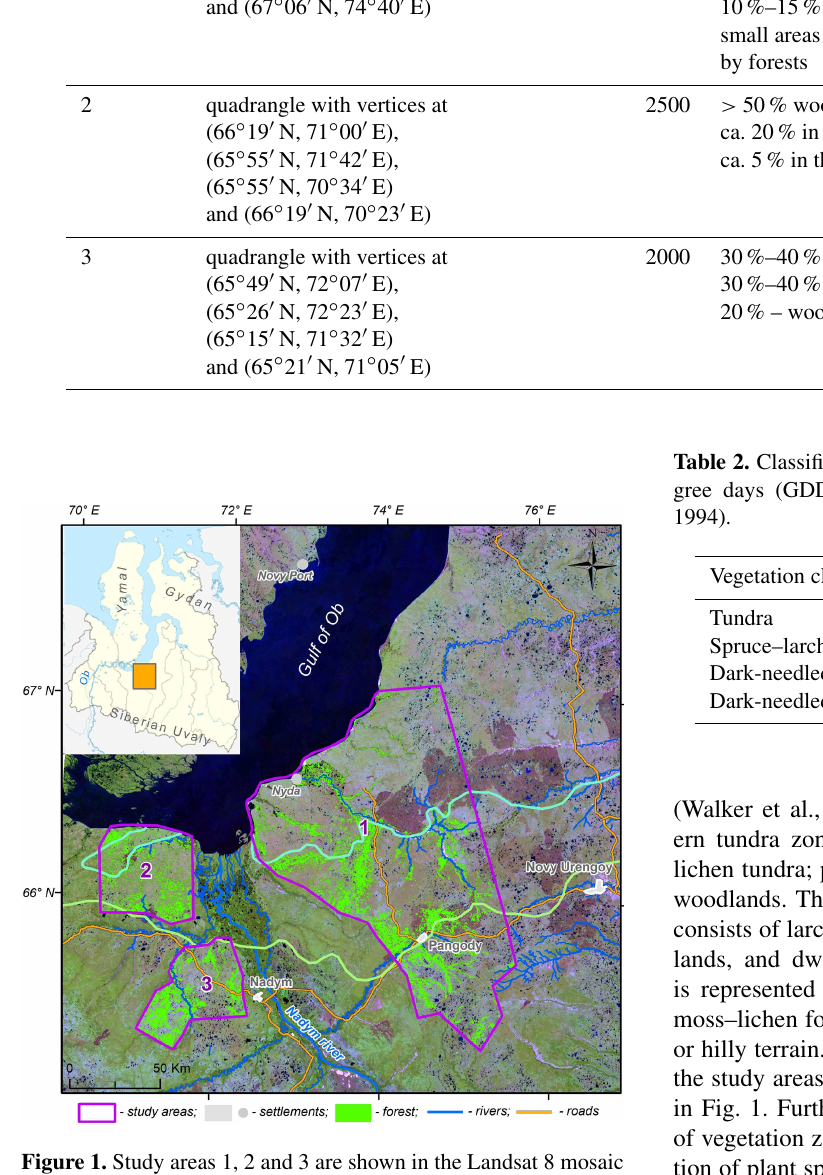
Figure 1. Study areas 1, 2 and 3 are shown in the Landsat 8 mosaic (2018). Green areas display the forest mask obtained from the to- pographic map (Ilyina et al., 1985). Cyan curve is the boundary be- tween southern tundra and tundra–forest ecotone; light green curve is the boundary between forest–tundra ecotone and northern taiga (Ilyina et al., 1985). Inset: orange rectangular region marks the lo- cation of the study sites on the map of Yamalo-Nenets Autonomous Okrug.